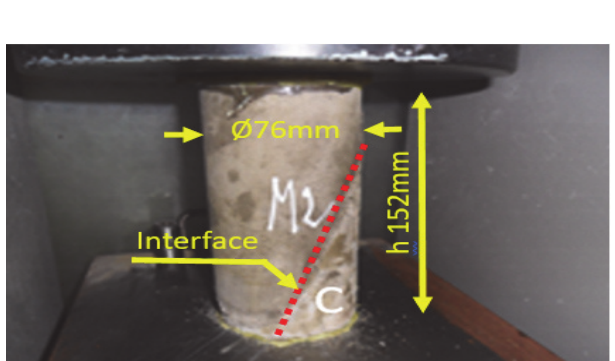
Figure 3: Composite cylinder samples subjected to slant shear.